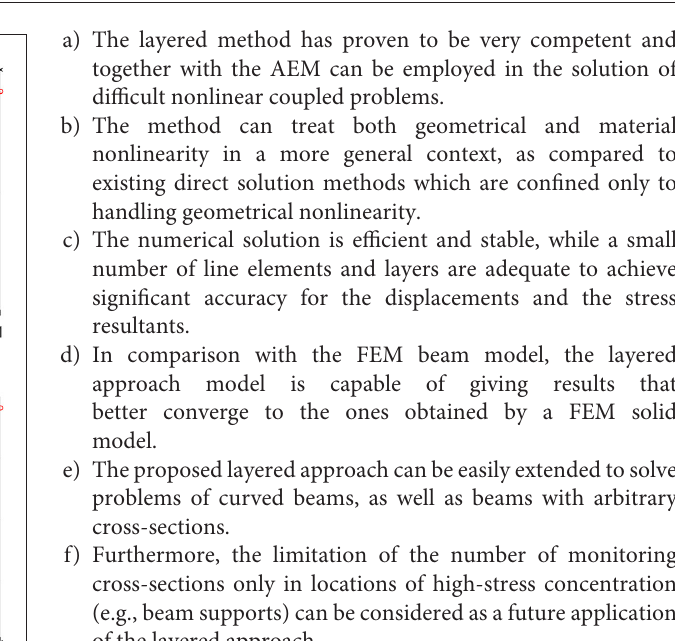
FIGURE 13 | Deflection at the middle of the beam vs. load in Example 3.